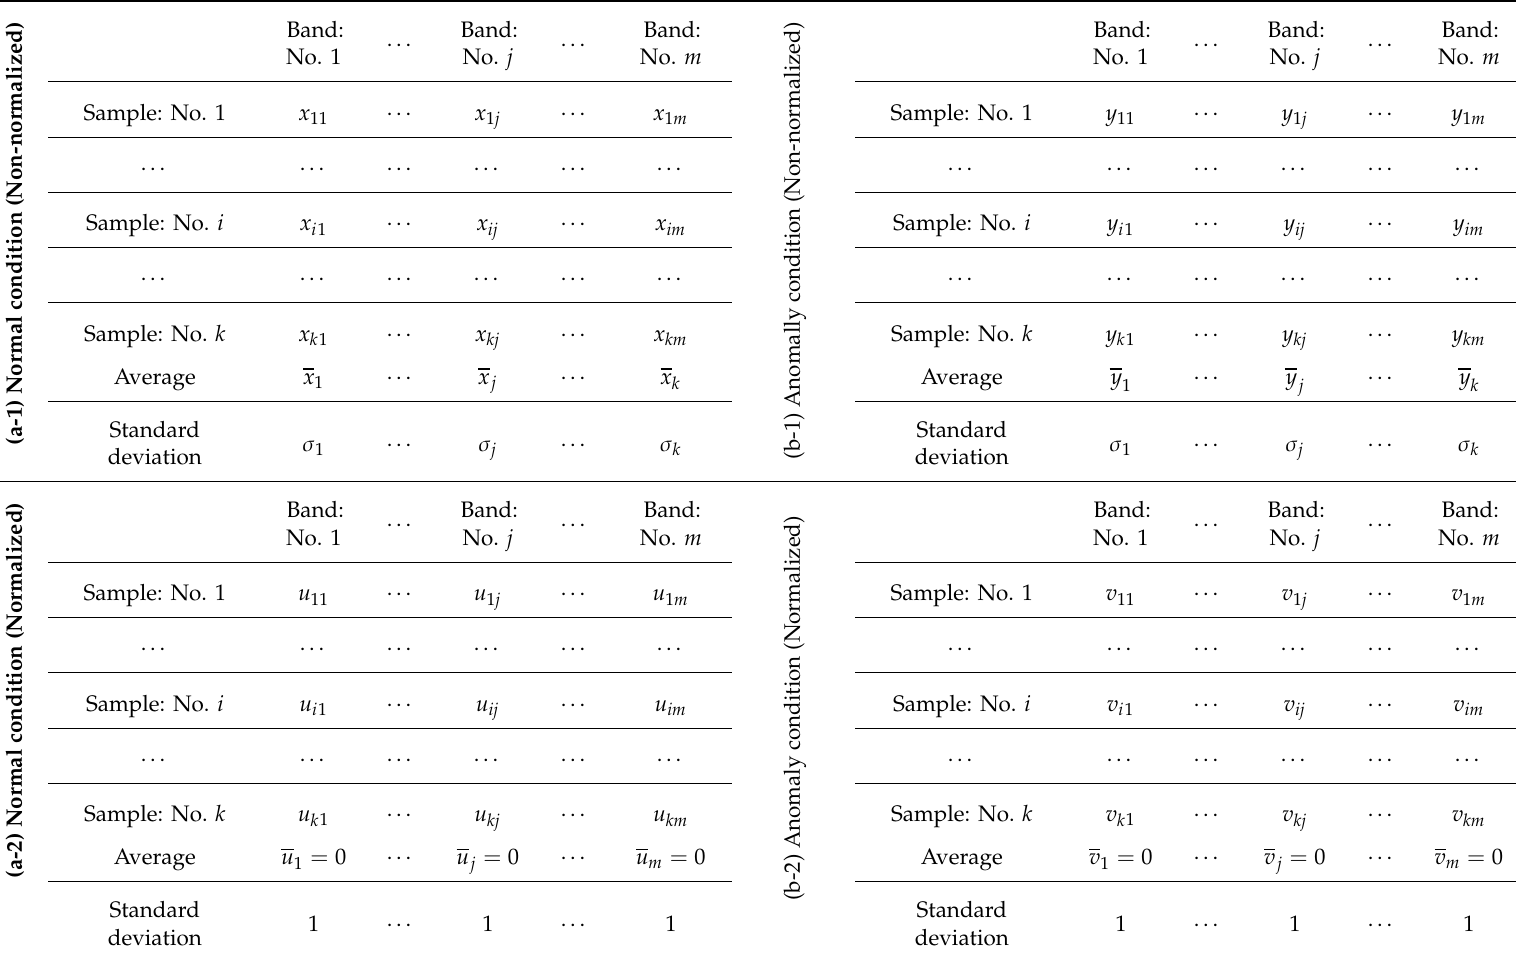
Table 1. Normalization scheme for the vibration energy levels in each of the frequency